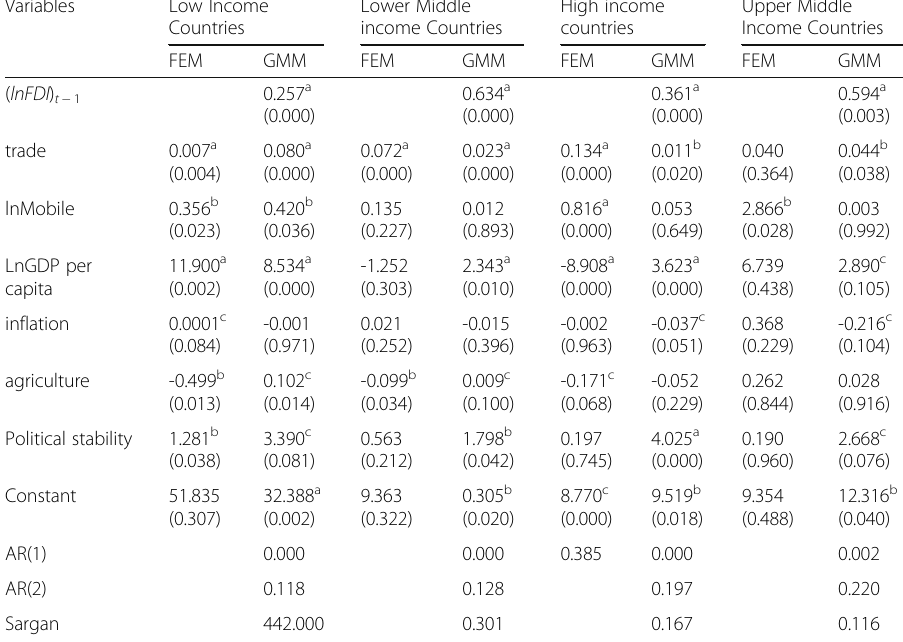
Table 12 Political stability and FDI Variables